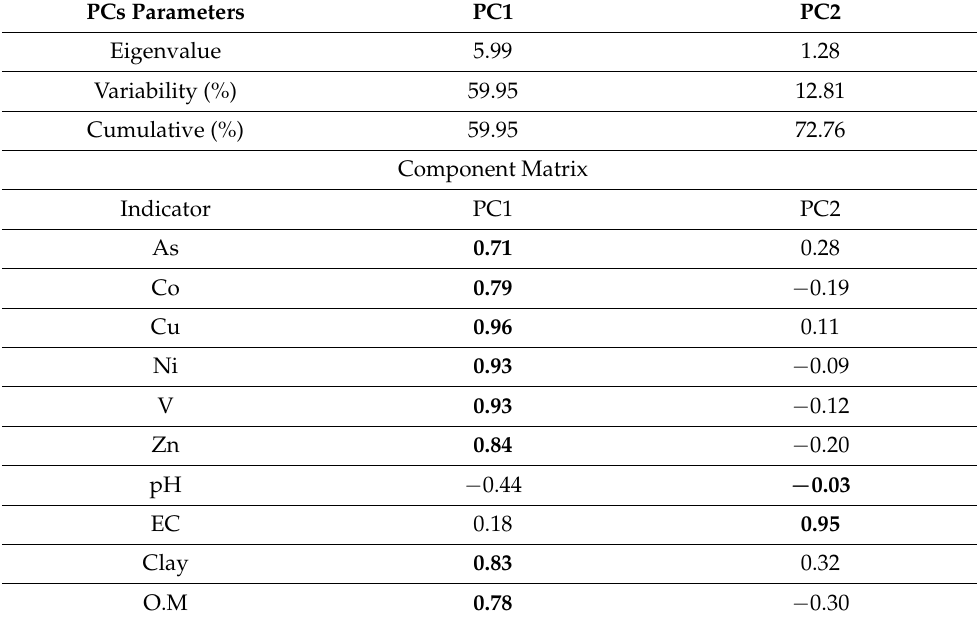
Table 3. Principal component analysis (PCA) analysis summary.